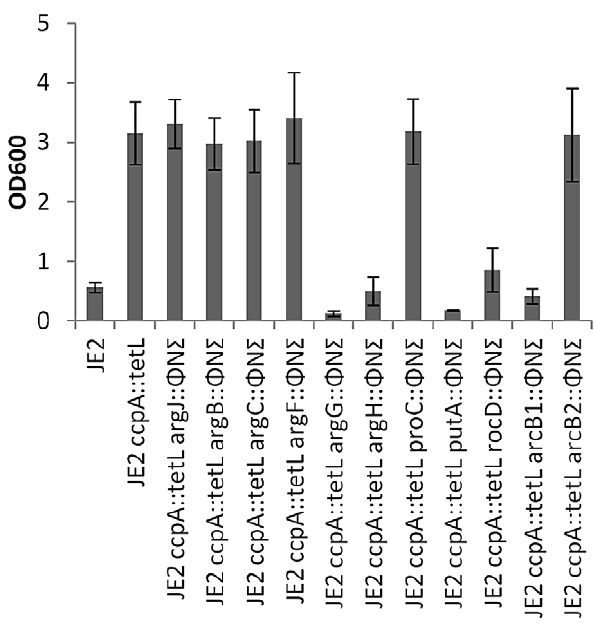
Figure 5. Determination of arginine biosynthesis-dependent genes in S.aureus JE2 ccpA::tetL . Defined bursa aurealis transposon mutants in argJ , argB , argC , argF , argG , argH , proC , putA , rocD , arcB1 , and arcB2 were transduced into JE2 ccpA::tetL and assessed for growth in CDM-R for 18 hours. Data represent means 6 SEM of three independent experiments.